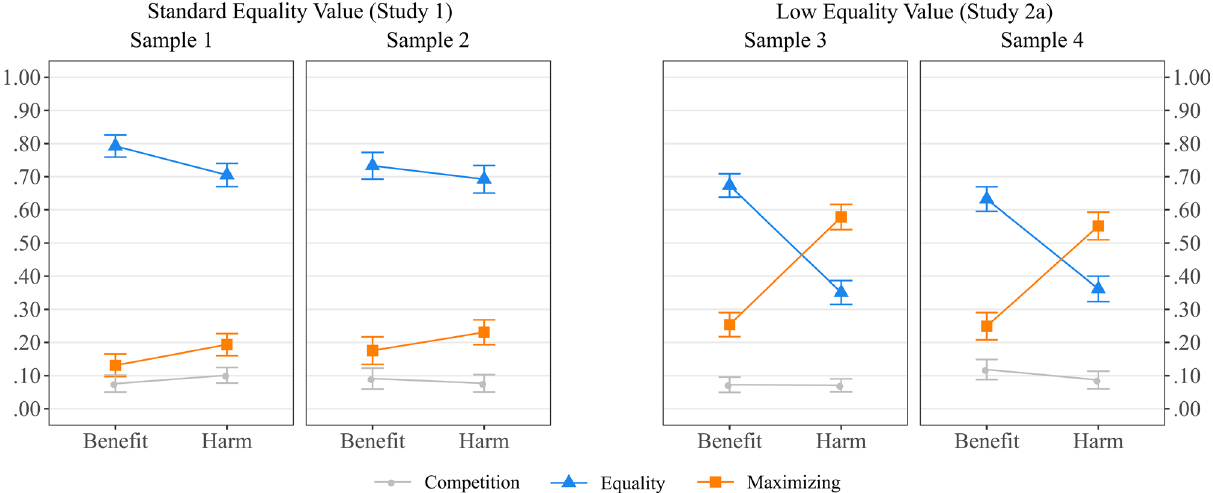
Figure 3. Proportion of Equality, Maximizing, and Competition choices as a function of type of outcome (Benefit versus Harm) and Equality option value (Standard versus Low) across the four samples of Study 1 and Study